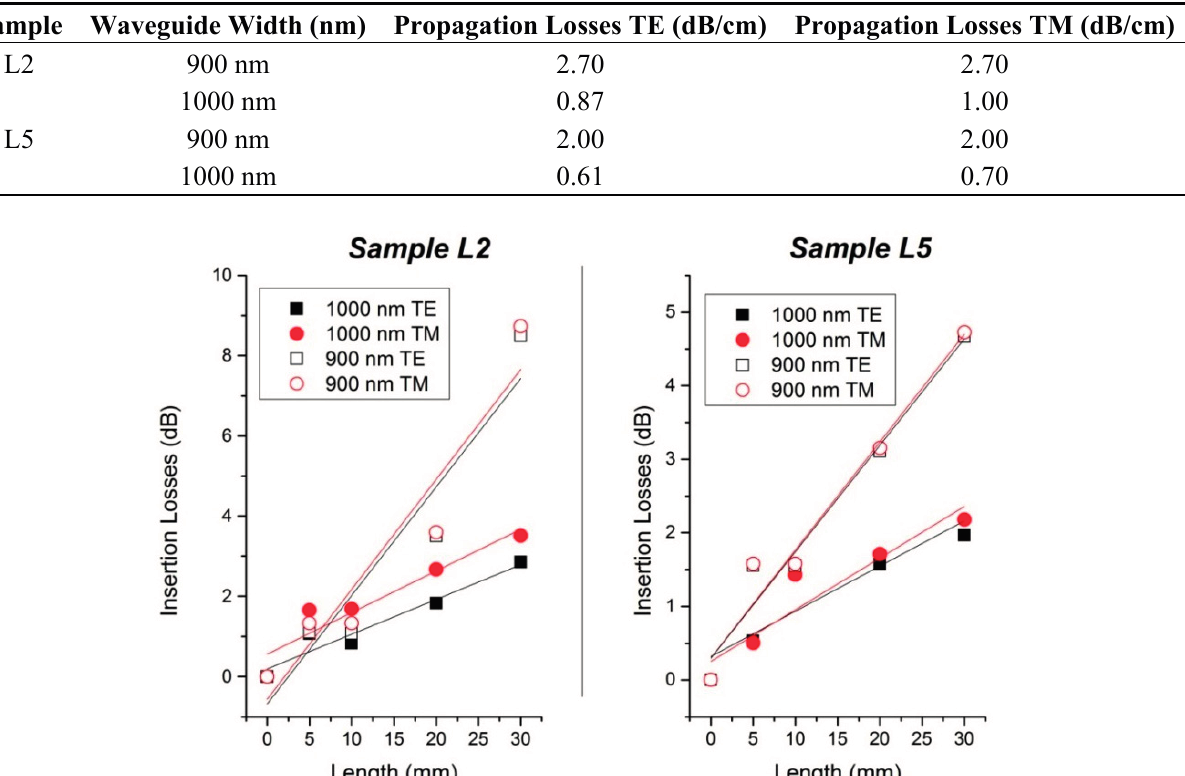
Table 2. Propagation losses of L2 and L5 samples.